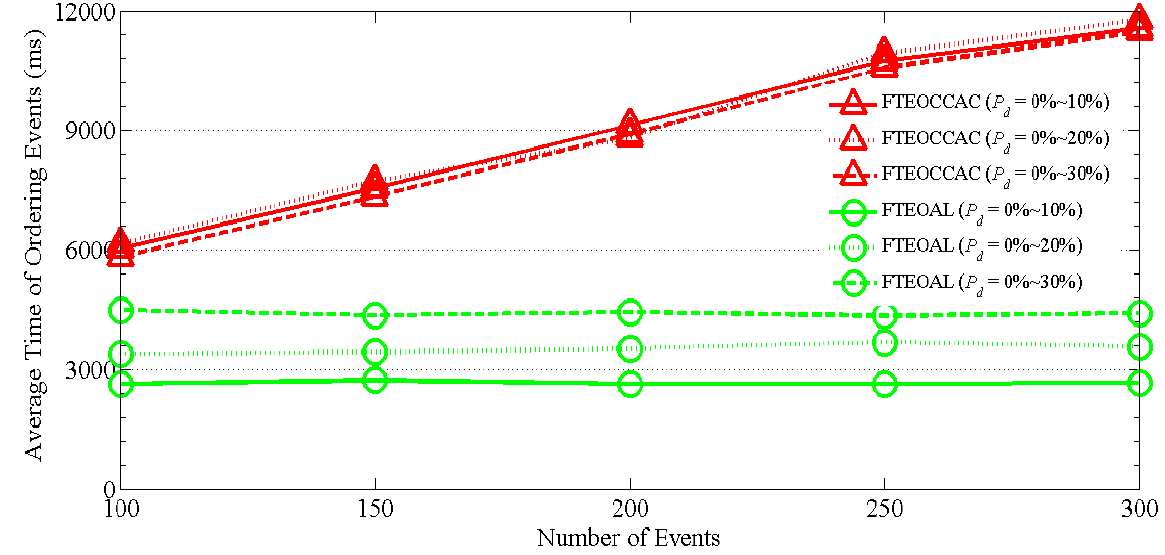
Figure 9. AT in FTEOCCAC and OBDC for different P d ( DTG = 100 ms, DT = 2000 ms, P l =